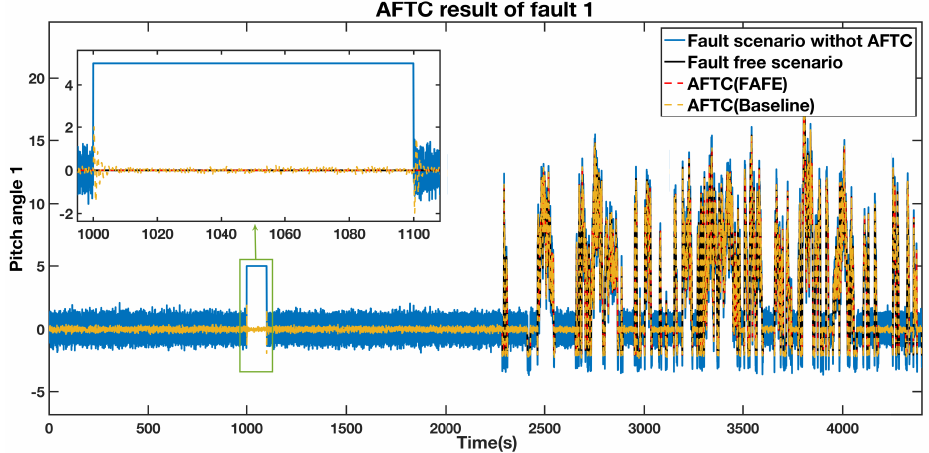
Figure 4. AFTC Results Comparison of the pitch angle 1